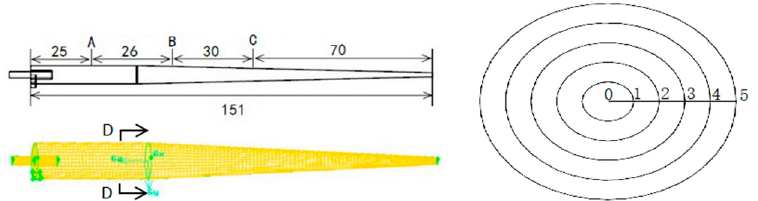
Figure 1. The axial length of Z axis and cross section of the cylinder of the hydrocyclone.